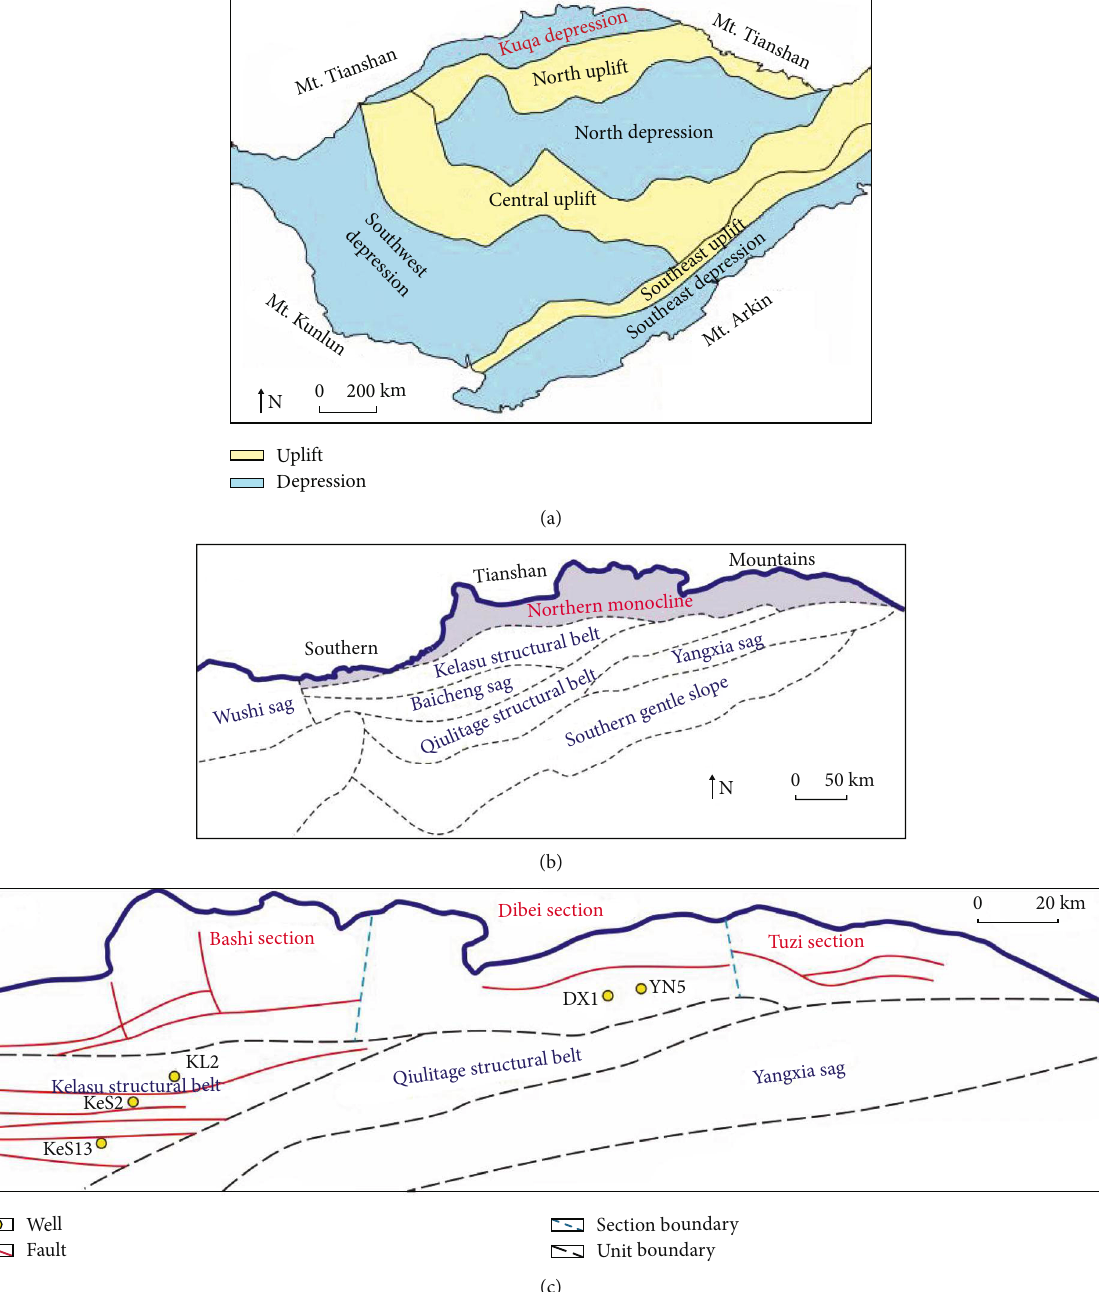
Figure 1: Division of structural units in the Kuqa Depression and structural location of the Dibei gas reservoir. (a) The Kuqa Depression is located in the northern margin of Tarim Basin, and it is divided into seven fi rst-order structural units, which are the Kuqa Depression, Northern Uplift, Northern Depression, Central Uplift, Southwestern Depression, Southeastern Uplift, and Southeastern Depression; (b) the Kuqa Depression is divided into seven second-order structural units, which are the northern monoclinal belt, Kelasu tectonic belt, Qiulitage tectonic belt and southern slope belt, the Wushi sag, Baicheng sag, and Yangxia sag; (c) the northern monoclinal belt is divided into three tectonic segments: the Bashi section, Dibei section, and Tuzi